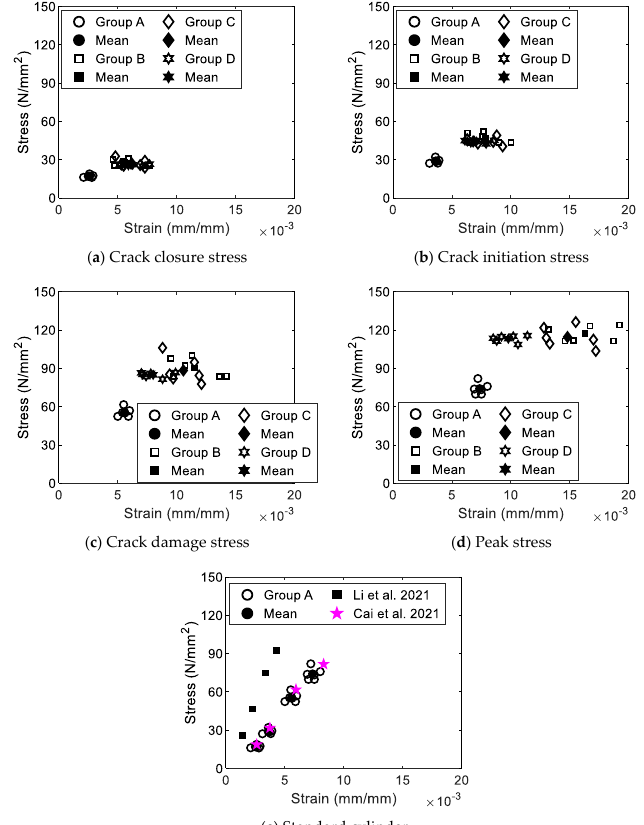
Figure 7. Threshold